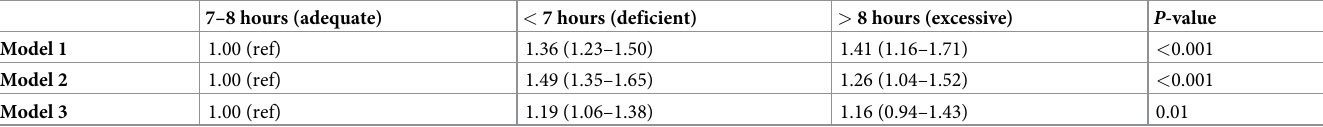
Table 3. Odd ratios and 95% CI relating duration of sleep to